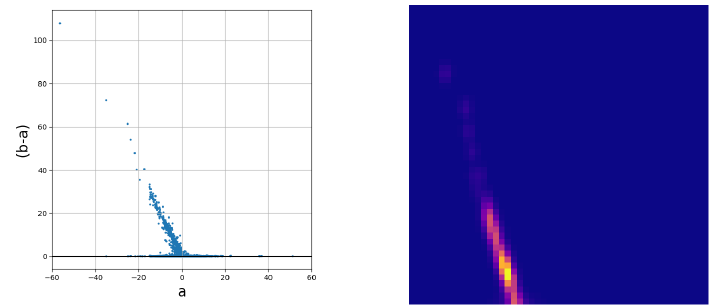
Figure A8. Tense passenger with rigid seat.